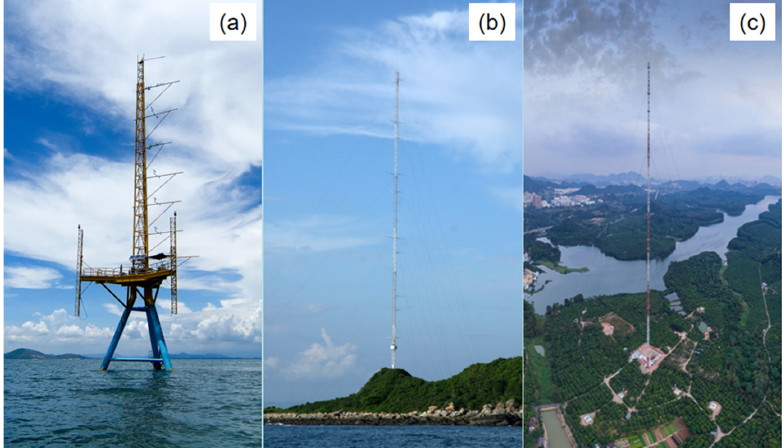
Figure 1. The snapshots of ( a ) the tower over sea, ( b ) the tower on island, and ( c ) the tower on